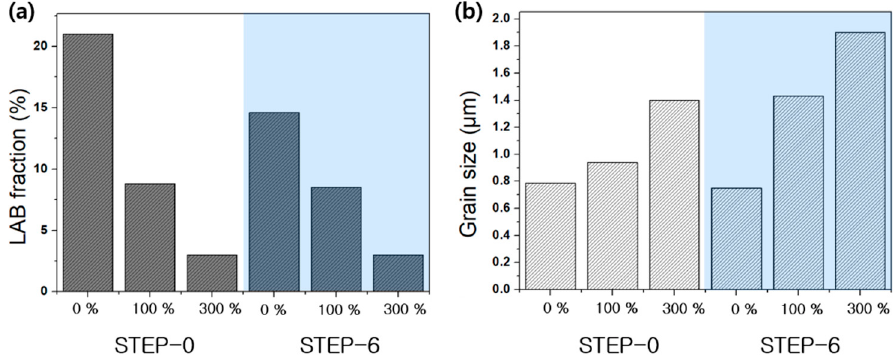
Figure 9. Microstructural features of STEP-0 and STEP-6 samples after strains of 0%, 100%, and 300% at 650 ° C and 10 − 3 s − 1 : ( a ) LAB fraction, ( b ) average grain size.